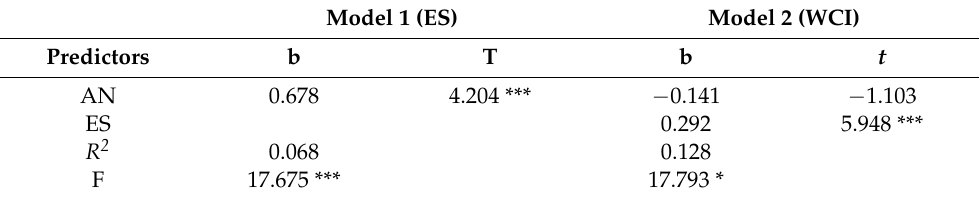
Table 4. The mediating effect of anthropomorphism on wildlife conservation intention. Model 1 (ES) Model 2 (WCI)